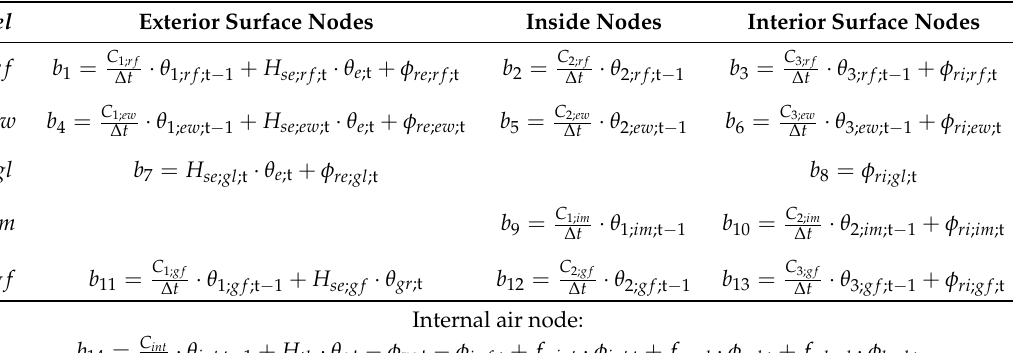
Table A2. Elements b 1 , · · · , b 14 of matrix b . el refers to the five building element